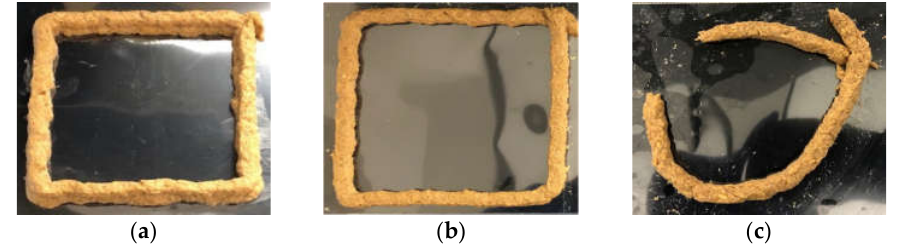
Figure 8. Printed samples using three mixtures with different levels of psyllium husk powder: ( a ) mixture B (wp/vw = 1:40); ( b ) mixture C (wp/vw = 2:40); ( c ) mixture D (wp/vw = 3:40).